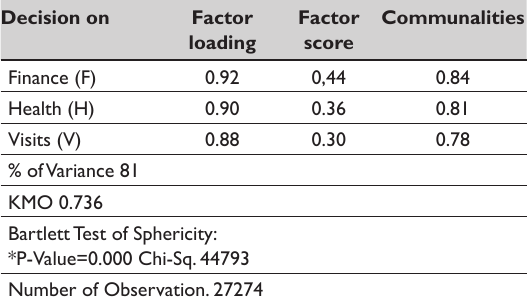
Table 1a: Results of the constructing the autonomy index Decision on